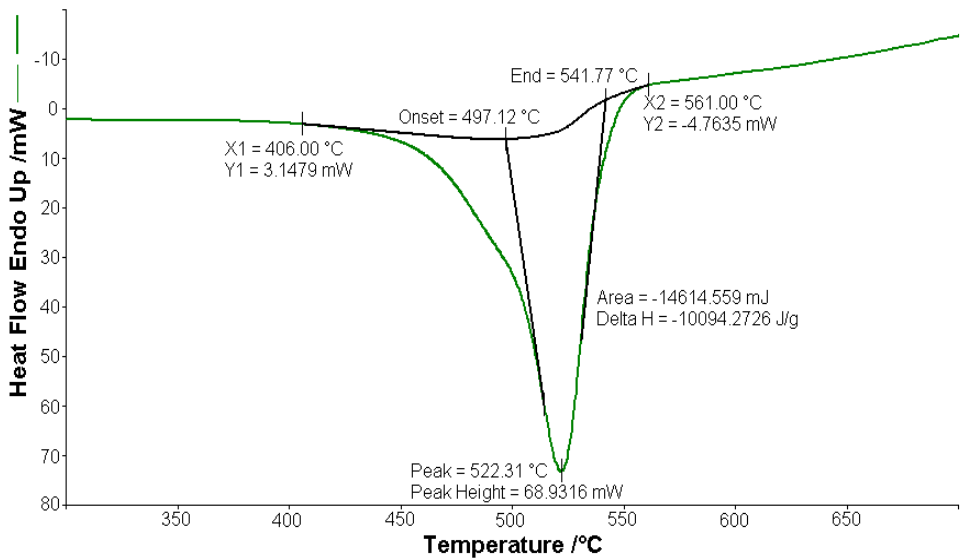
Figure 4. Exothermic peak ( ∆ H = − 10094.2 J g − 1 ) on the DSC curve at 522.31 °C for [CoL 2 ] ∙ 1.5H 2 O.